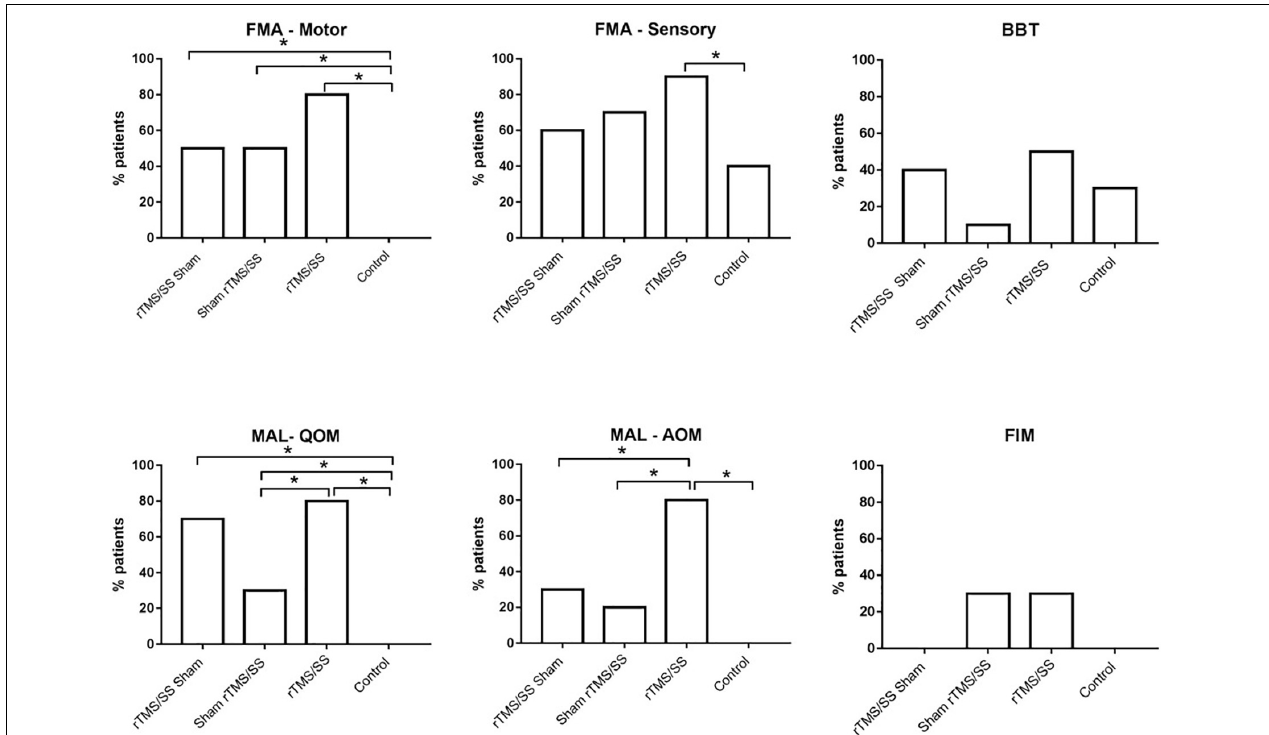
FIGURE 3 | Proportion of subjects who reached the minimal clinically important difference (MCID) for each group. * p -value < 0.05 Chi square. BBT, Box and Block Test; FMA-Sensory, upper limb Fugl-Meyer assessment for sensory function; FMA-Motor, upper limb Fugl-Meyer assessment for motor function; FIM, Functional Independence Measure; MAL, Motor Activity Log; QOM, the quality of upper limb movement of Motor Activity Long test; MAL-AOM, amount of upper limb movement of Motor Activity Long test. SS, sensory stimulation; rTMS, repetitive transcranial magnetic stimulation.